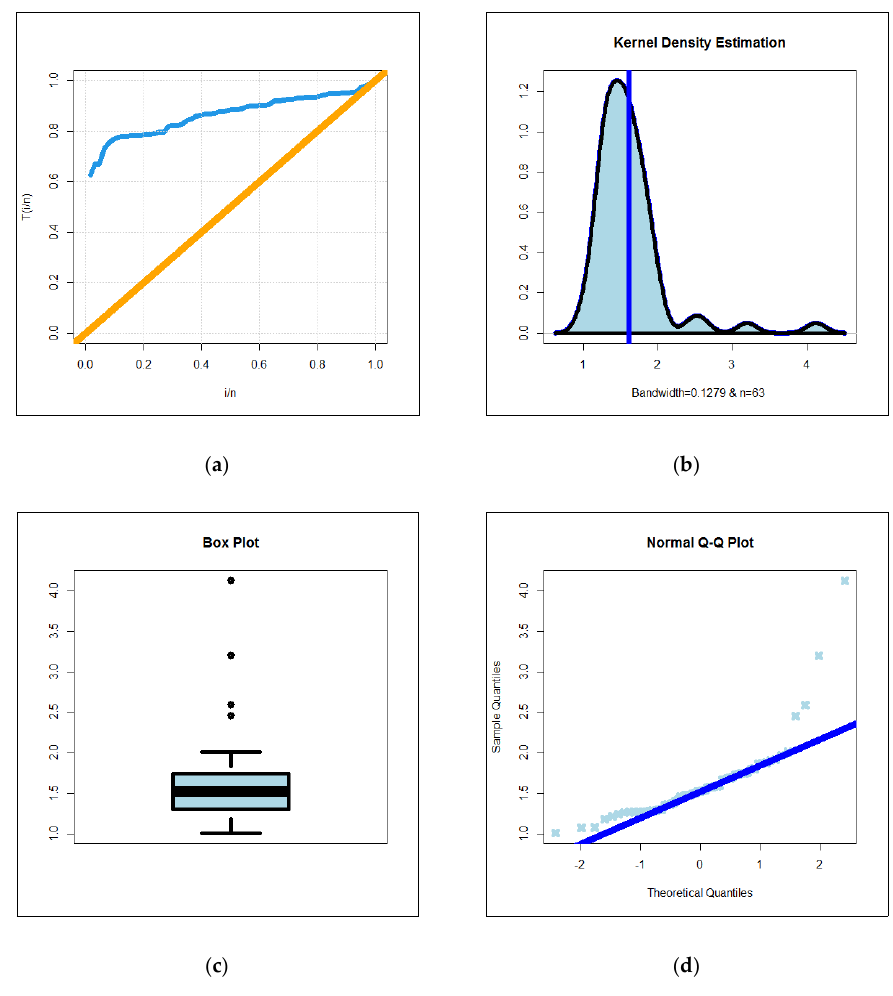
Figure 4. ( a ) TTT plot; ( b ) KDE plot; ( c ) box plot; ( d ) Q–Q plot for data set II .